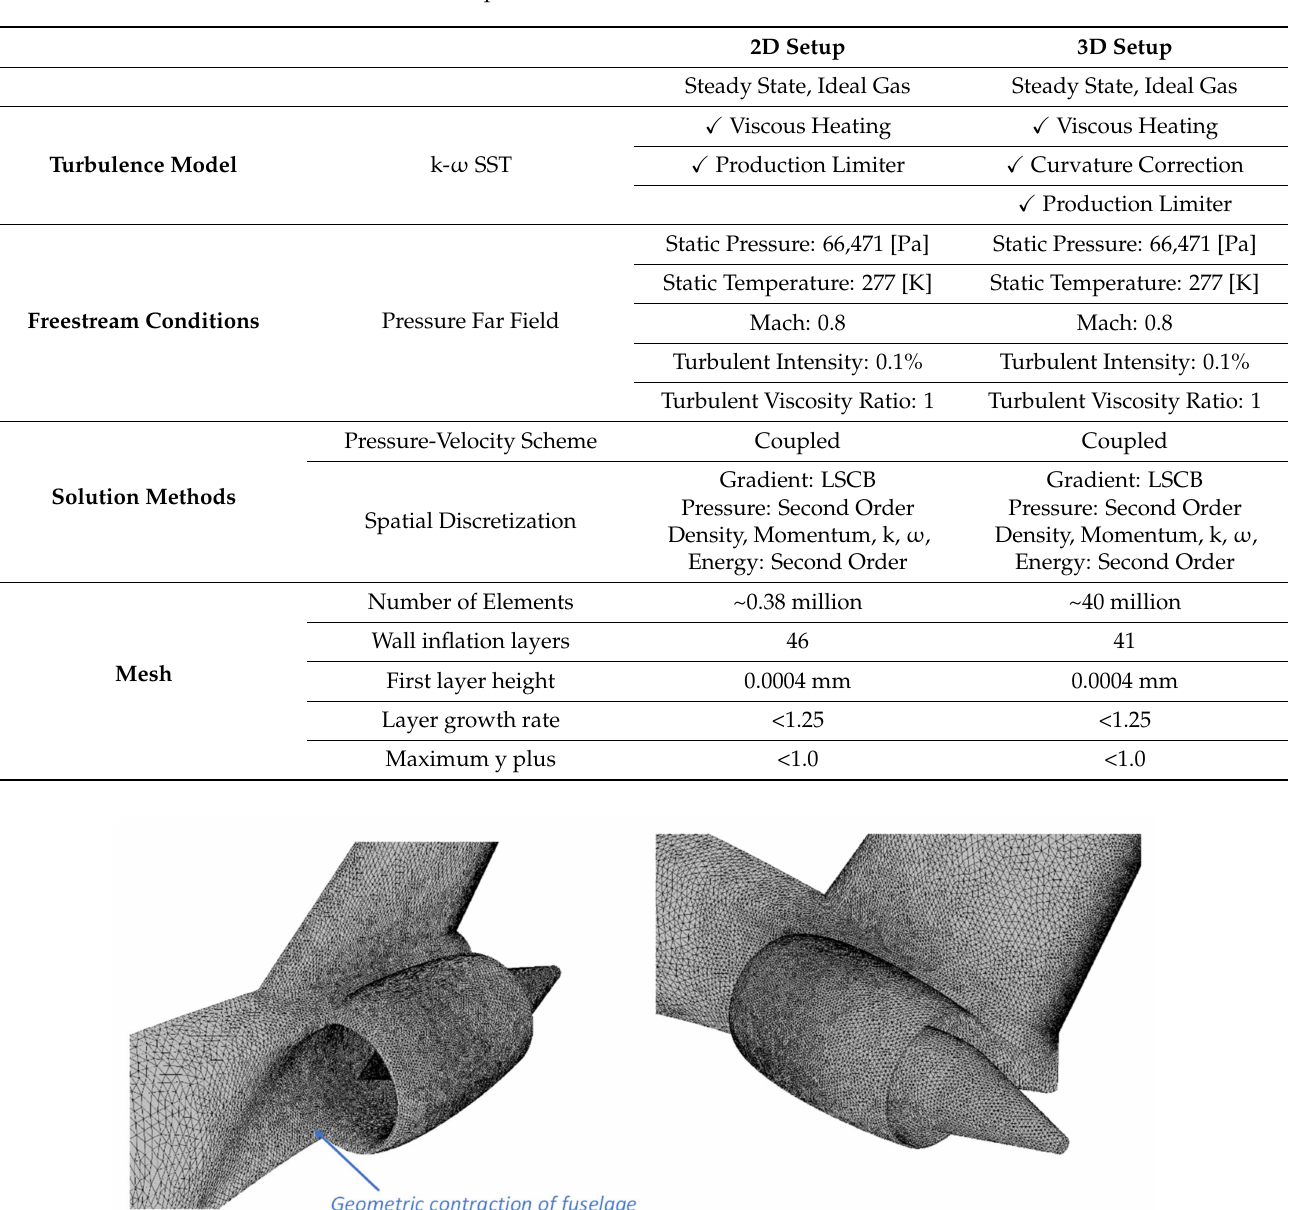
Table 2. CFD setups for the simulations.